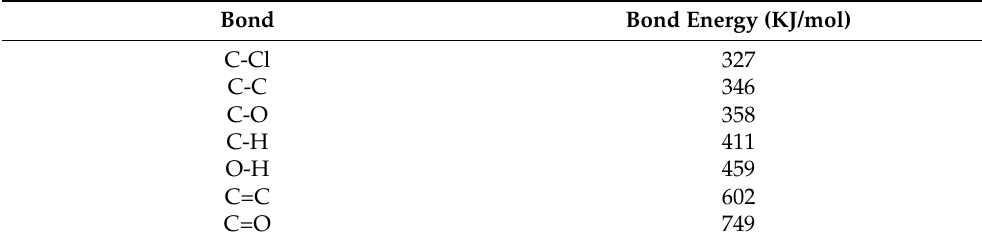
Table 2. Bond energies at 273K adapted from Ref.